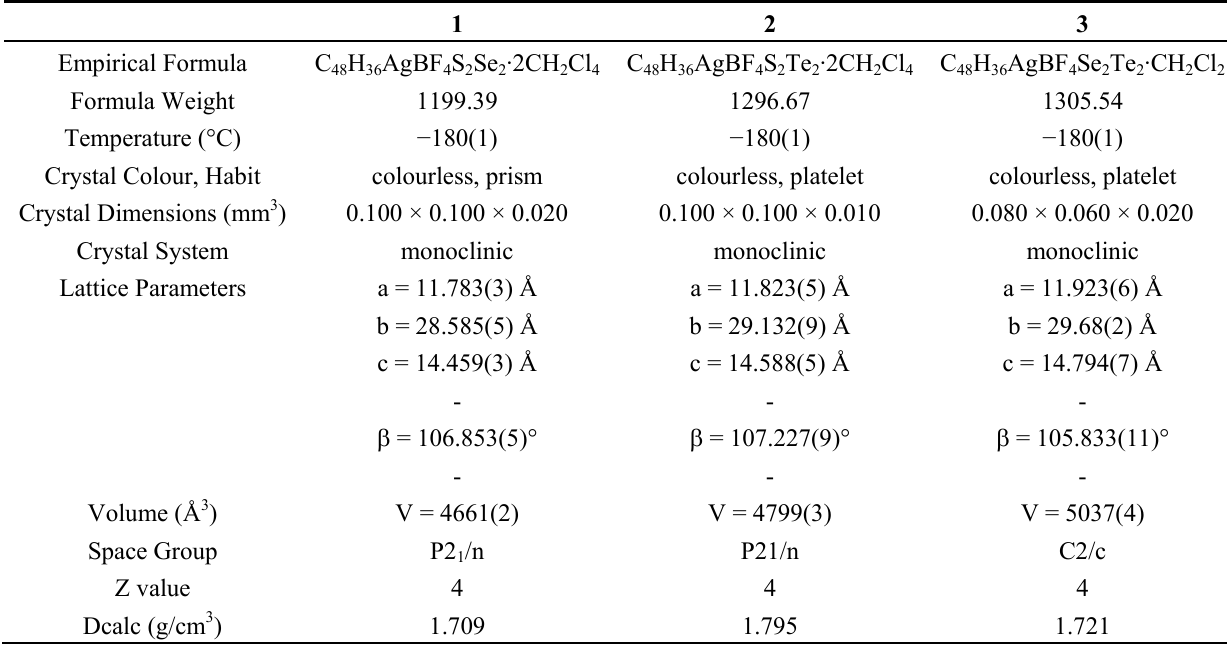
Table 4. Crystallographic data for 1 – 3